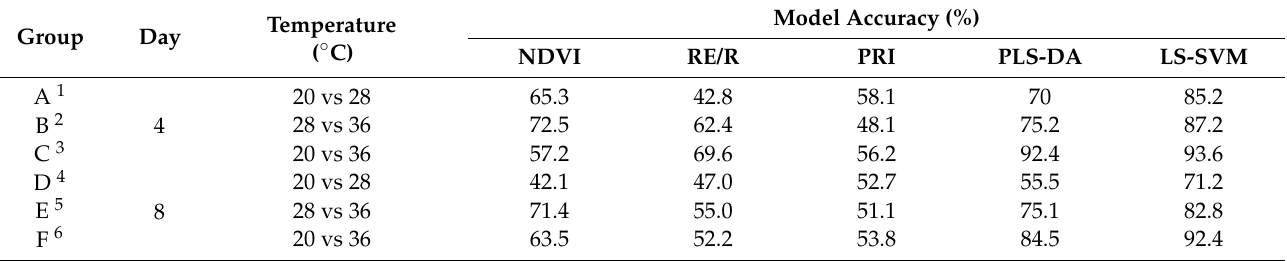
Table 4. Classification accuracy of normalized vegetation index (NDVI), red-edge ratio (RE/R), photochemical reflectance index (PRI), partial least squares-discriminant analysis (PLS-DA), and least-squares support vector machine (LS-SVM) models.